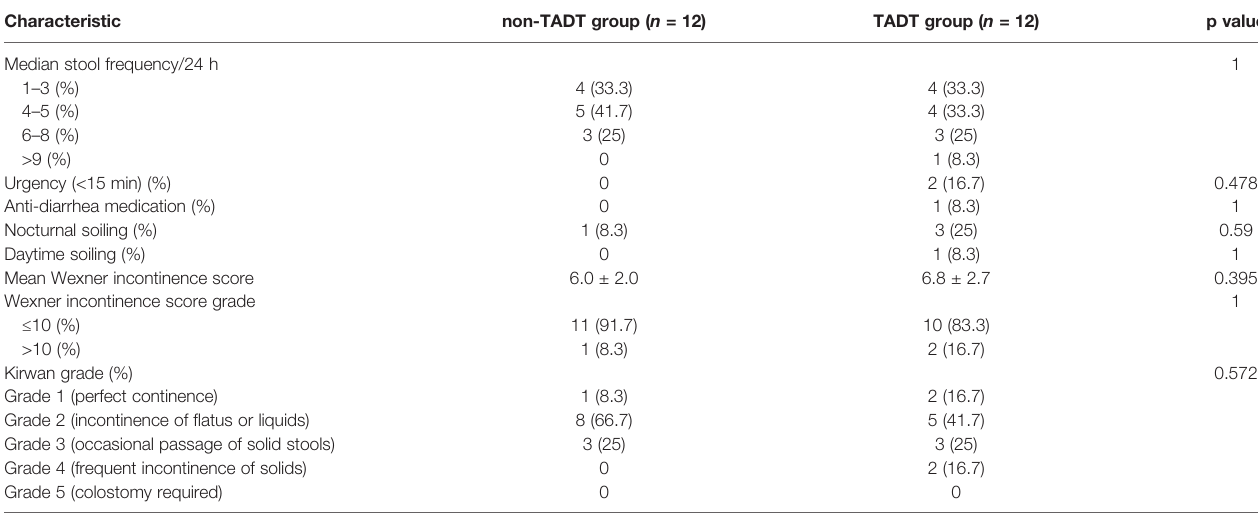
Values are means ± standard deviations or medians with ranges in parentheses